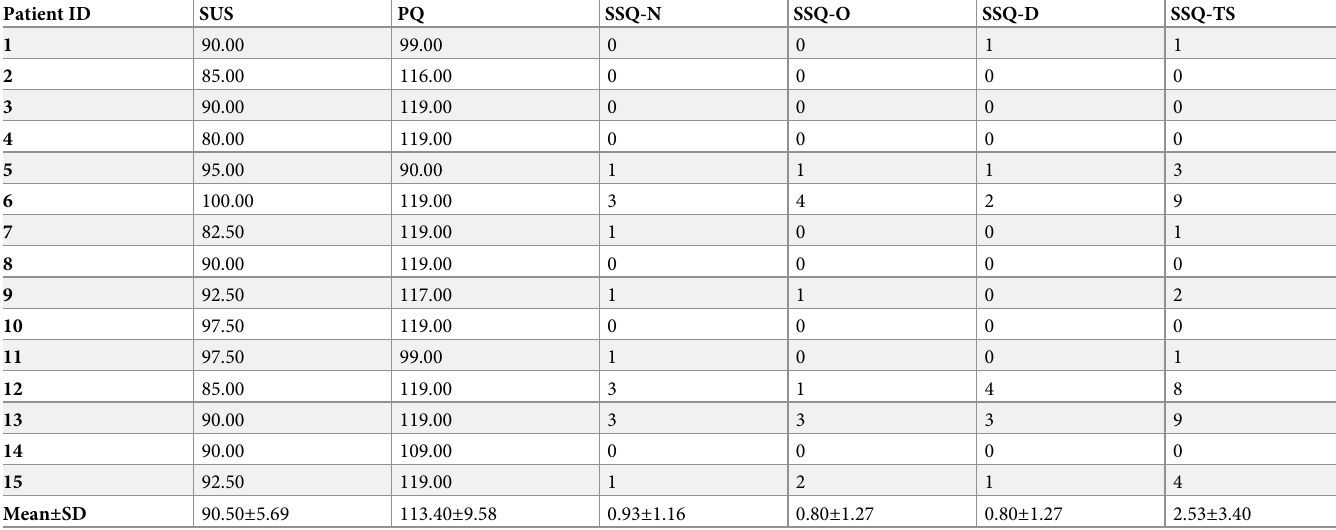
Table 4. SUS, PQ, and SSQ